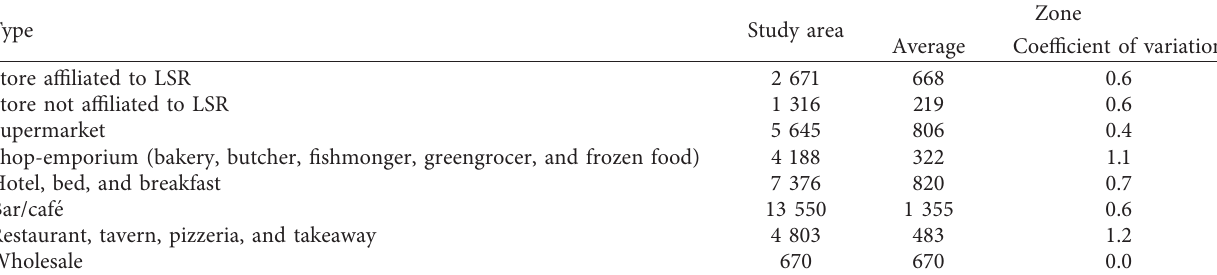
Table 6: Retail data: surface (m 2 ).